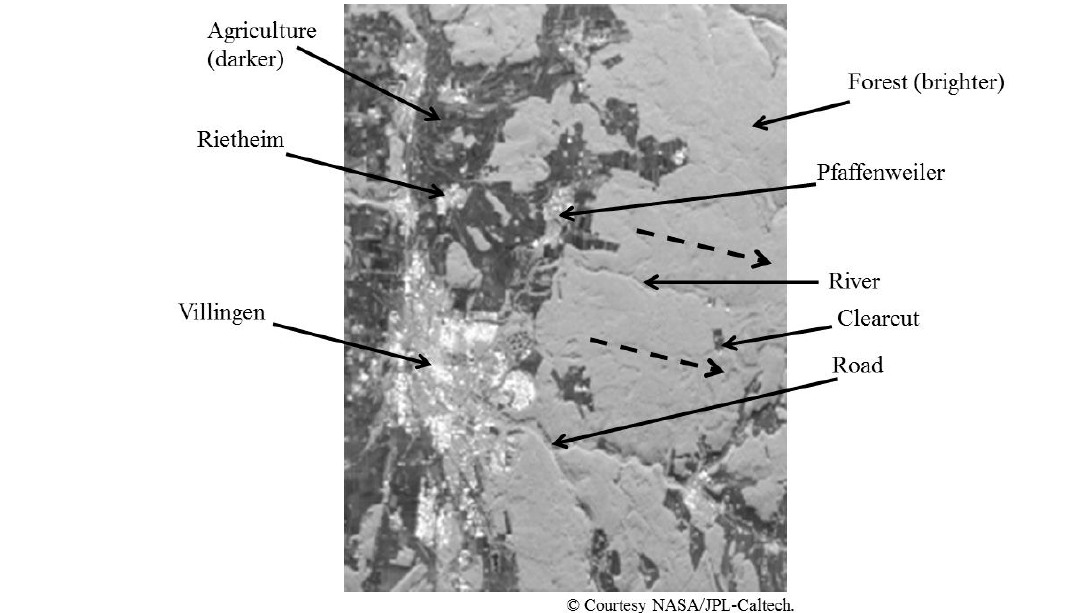
Figure 2. L-band image of the Black Forest in Germany obtained by the NASA / JPL AIRSAR system in the summer of 1991. The solid arrows indicate the name of city or area type. The dotted lines specify the direction of topographic change. The terrain slopes upward in the direction of the arrows [21].